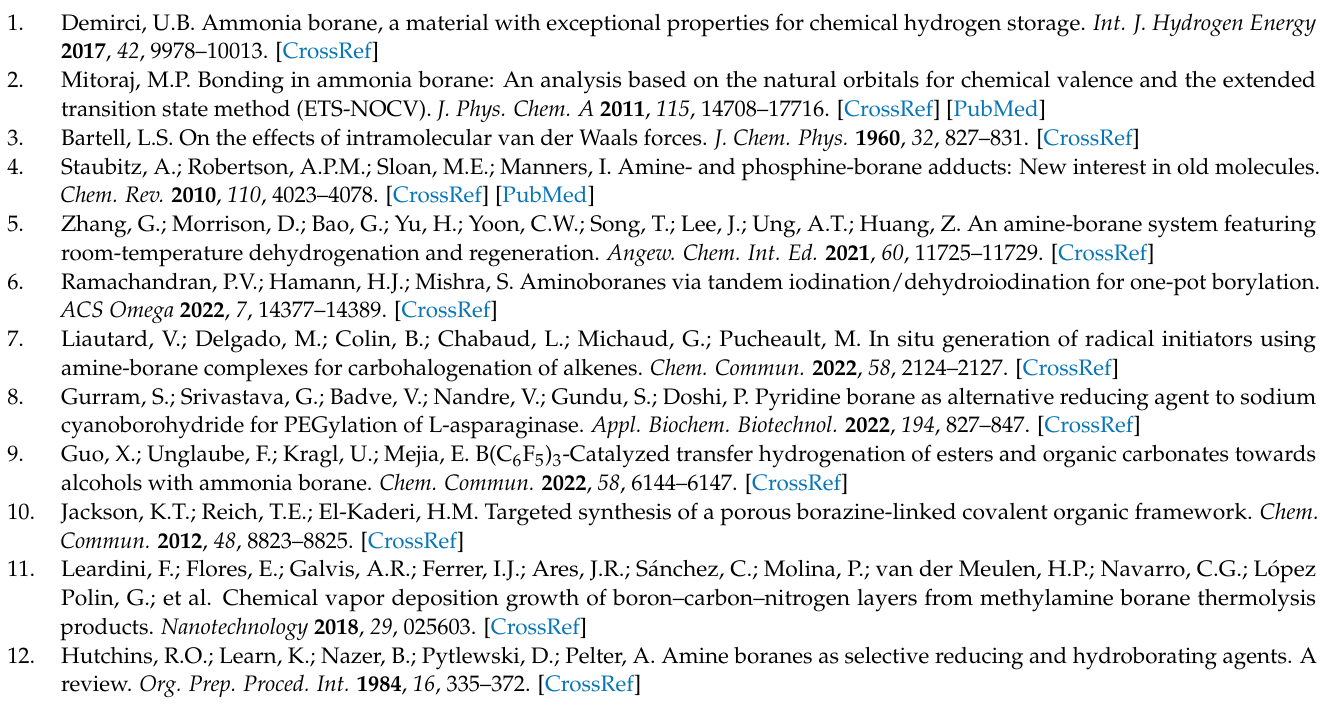
(right axis) curves of C3AB; Figure S22. Thermal decomposition of C3AB: evolution of the peak area of the volatile products detected by TGA/microGC-MS coupling as a function of the sampling temperature; Figure S23. TG curve of C2C6AB, superimposed with the evolution of H2 as obtained by TGA/microGC-MS; Figure S24. TG (left axis) and DTG (right axis) curves of C2C6AB; Figure S25.